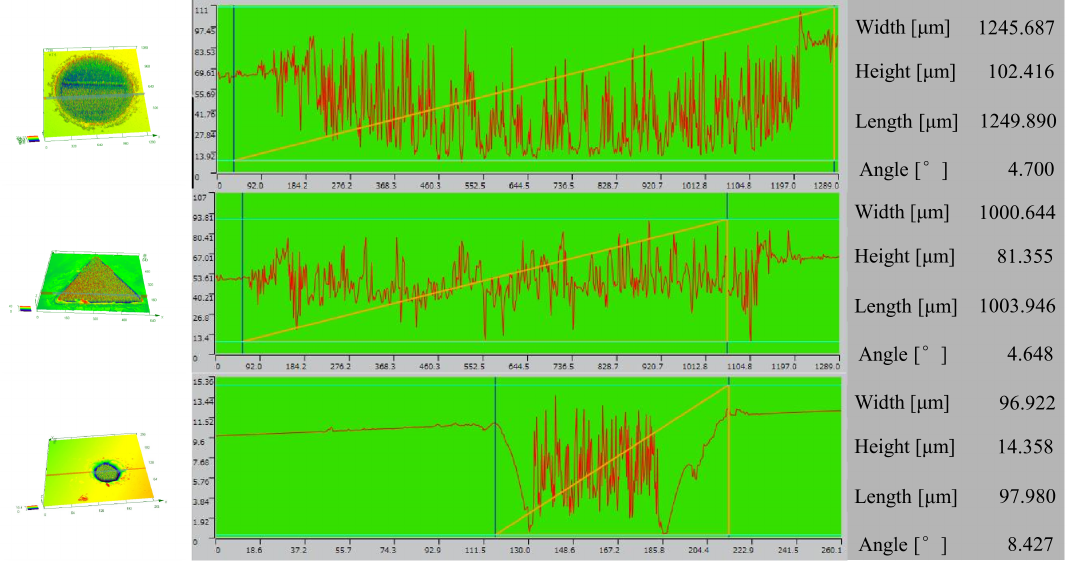
Figure 12. Three-dimensional topography of a blind